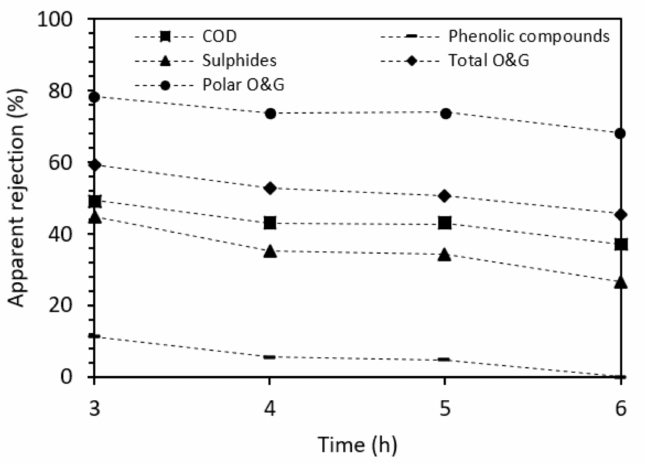
Figure 9. Apparent rejection of contaminants during separation with the 200 Da ceramic membrane.